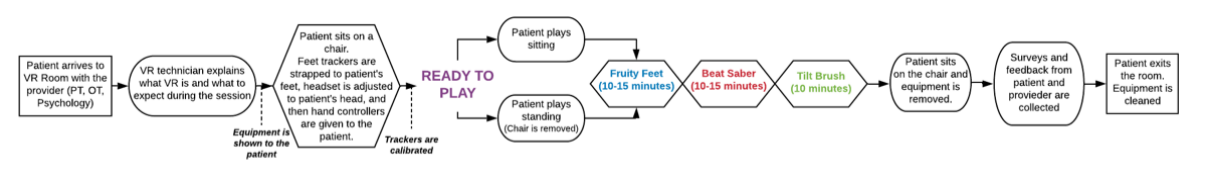
Figure 1. VR session flowchart. Patient arrives to session with clinician who orients patient to the use of VR equipment safely. While seated, foot and hand trackers are placed, and VR headset adjusted on patient. Clinician has patient begin while seated initially to orient to VR system and then eventually standing, as deemed appropriate. Three VR programs were utilized for approximately 10 minutes each (Fruity Feet, Beat Saber, and Tilt Brush). After the VR session, patient once again is seated to remove trackers and headset. Patient completes survey and both patient and clinician give feedback after each session. Equipment is thoroughly cleaned and sanitized following each session. VR: virtual